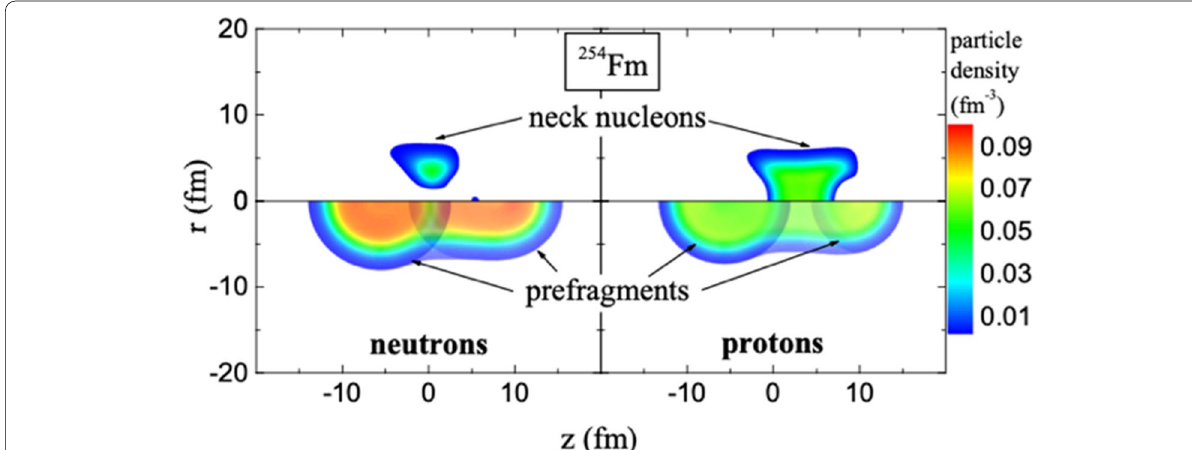
Fig. 17 Density distributions of prefragments (bottom) and neck nucleons (top) obtained from DFT calculation with UNEDF1 HFB . The figure is adapted from